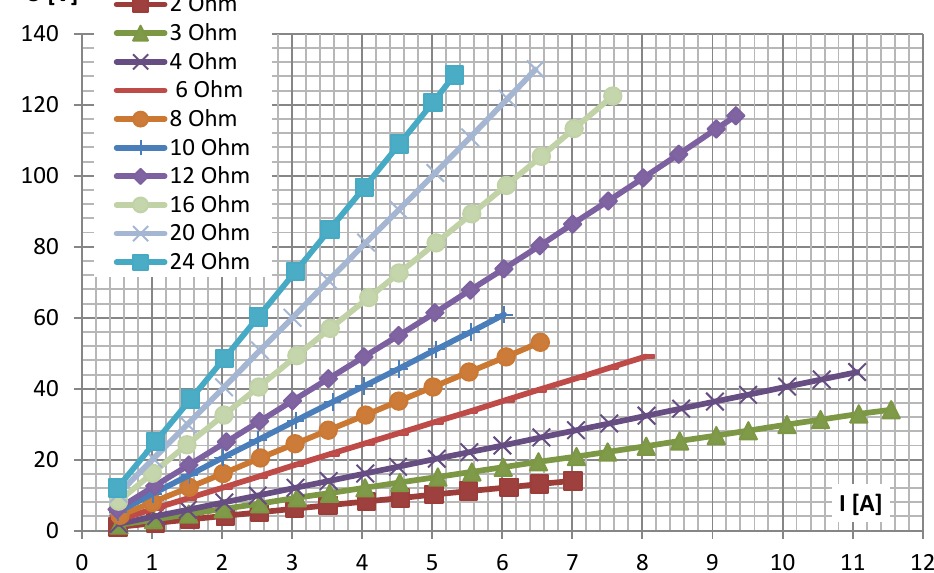
Figure 8. The rms values of the output current vs. output voltage of a badly designed audio power amplifier for resistive load.